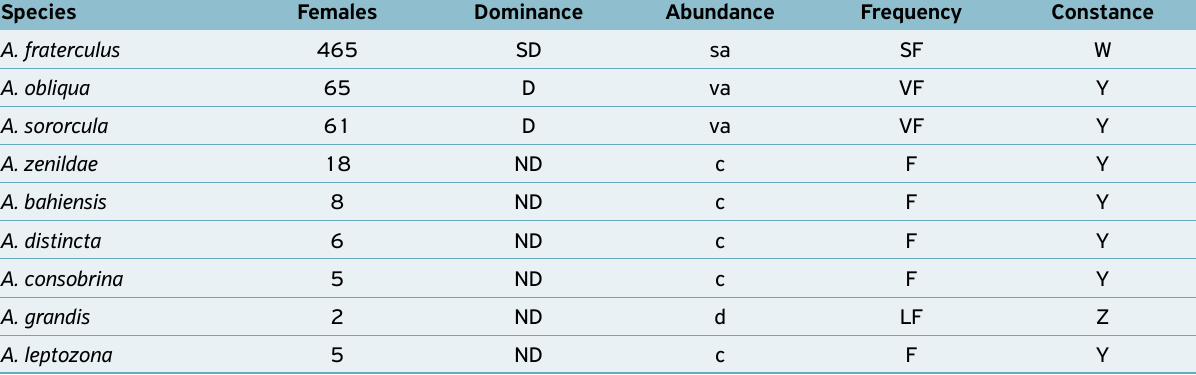
Table 3. Faunistic analysis of Anastrepha species captured in McPhail traps in Wenceslau Guimarães Bahia, July/2011–December 2012.